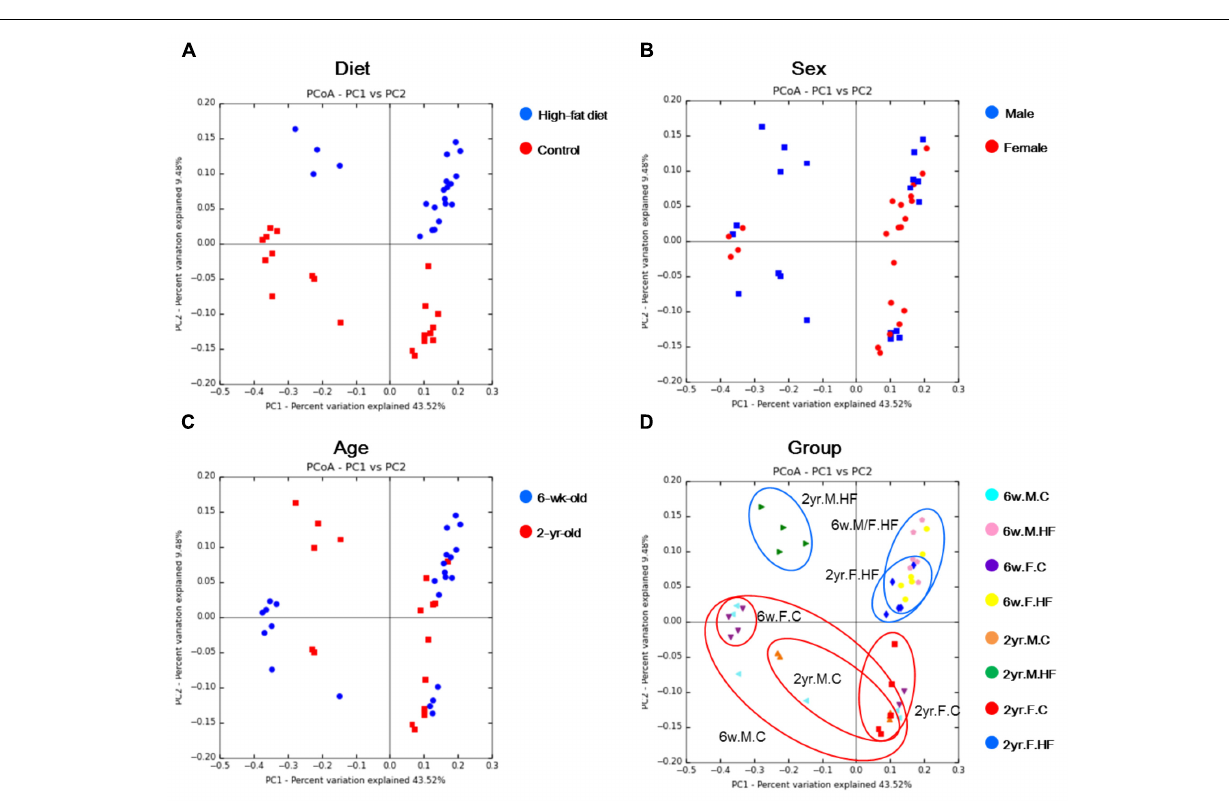
FIGURE 2 | PCoA plots of two ages per diet (A) , sex (B) , age (C) , and experimental groups (D) . Metagenome sequencing was performed with 16S rRNA from rat fecal samples. UniFrac-based PCoA was performed on the metagenome sequencing data. 6w.M.C ( n = 6); 6w.M.HF ( n = 6); 6w.F.C ( n = 6); 6w.F.HF ( n = 6); 2yr.M.C ( n = 4); 2yr.M.HF ( n = 4); 2yr.F.C ( n = 5); 2yr.F.HF ( n = 6). 6w, 6-week-old; 2yr, 2-year-old; M, male; F, female; C, control; HF, high-fat